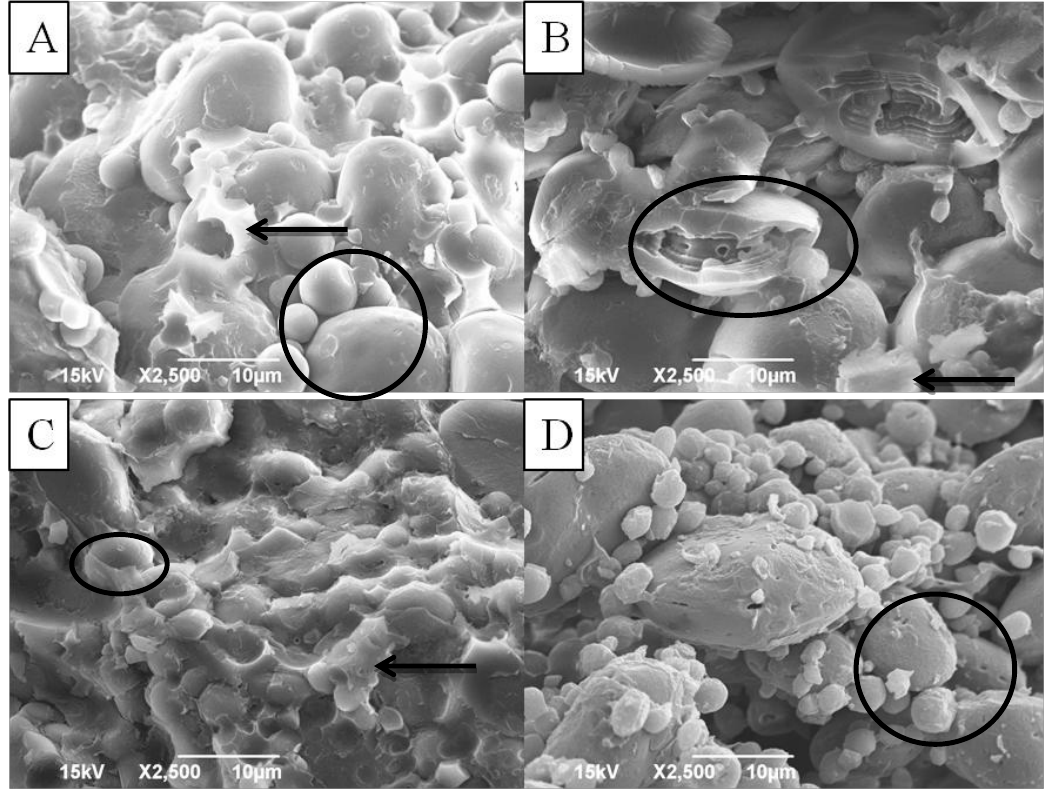
Figure 1. Scanning Electron Microscopy (SEM) images of starch from genotypes Steel-ND and Pristine. ( A ) Image from hard red spring (HRS) wheat genotype Steel-ND non-sprouted sample; ( B ) image from HRS wheat genotype Steel-ND sprouted sample; ( C ) image from hard white spring (HWS) wheat genotype Pristine non-sprouted sample; and ( D ) image from HWS wheat genotype Pristine sprouted sample. Starch granules are circled and protein matrix is identified by